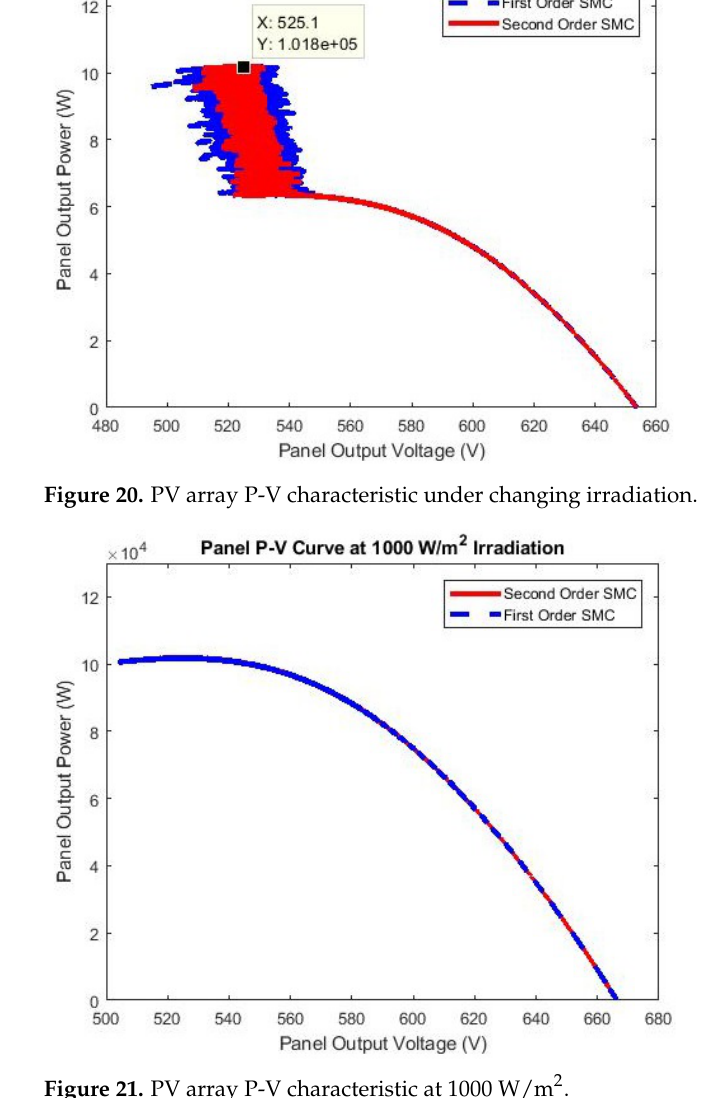
Figure 21. PV array P-V characteristic at 1000 W/m 2